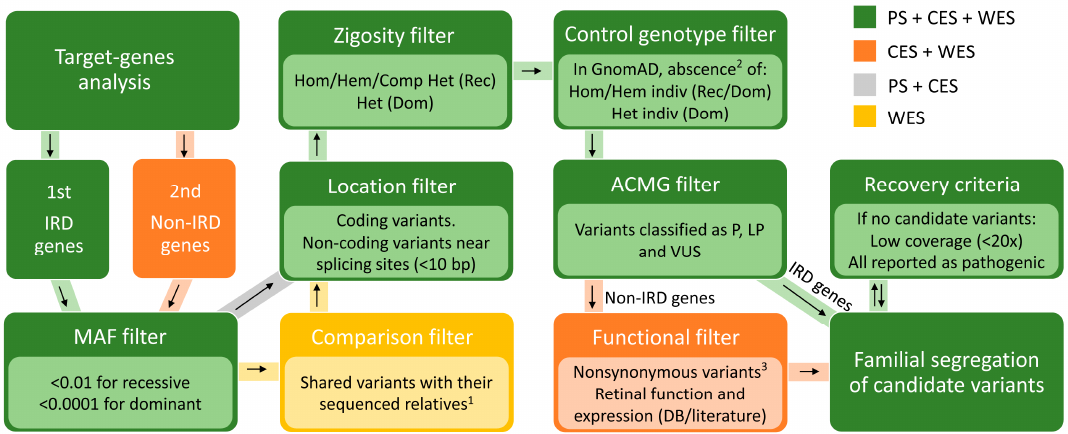
Figure 5. Overview of the prioritization steps performed in each strategy. Analysis of variants from panel sequencing (PS), clinical exome sequencing (CES) and whole exome sequencing (WES) using both recessive (Rec) and dominant (Dom) filters for autosomal and X-linked genes. Resulting candidate variants were subjected to familial segregation when possible. If no candidate or segregating variants were found, recovery criteria were applied to rescue pathogenic mutations that could have been filtered out. 1 Unshared variants were also considered to study genetic modifying factors in cases with intrafamilial phenotypic variability. 2 This step was only employed for variants non-previously reported as pathogenic or likely pathogenic. 3 Synonymous variants were not considered unless they were located in the last or first two bases of an exon. Comp het, Compound heterozygous; DB, Databases; Hem, Hemizygous; Het, Heterozygous; Hom, Homozygous; Indiv, Individuals; IRD, Inherited retinal dystrophies; LP, Likely pathogenic; P, Pathogenic; VUS, Variant of unknown significance.